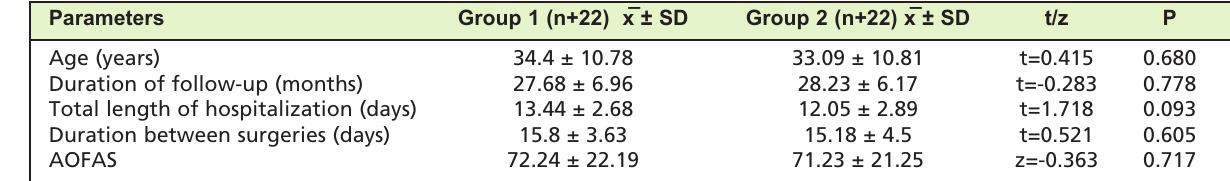
Comparison of continuous parameters in study groups Table I: